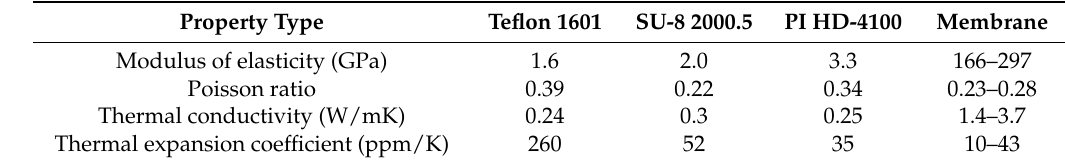
Table 4. Physical properties of the high molecular substances [14–19].